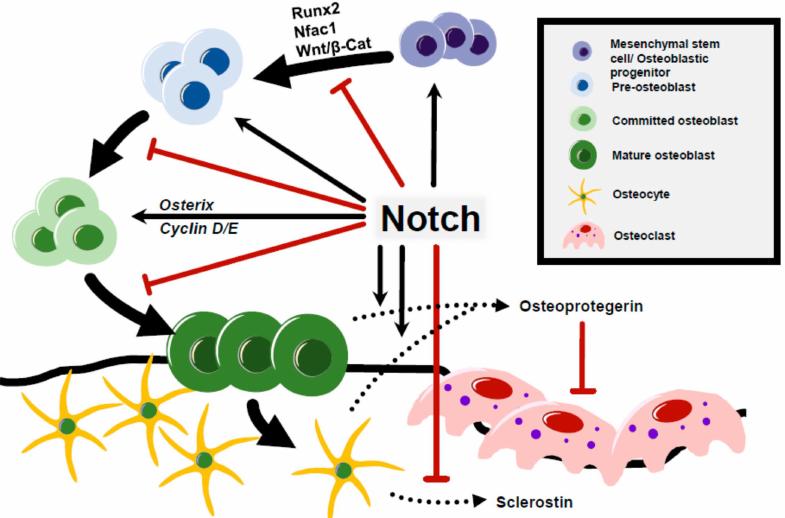
Figure 2. Notch regulation of osteoblast di ff erentiation and osteocyte function. Notch maintains the mesenchymal stem cell (MSC) pool by the repression of Runx2 transactivation on Osteocalcin and suppresses osteoblast di ff erentiation by the Nfatc1-mediated inhibition of Wnt / β -catenin signaling. Expression of Notch increases the immature osteoblast pool by upregulating transcription of Osterix, Cyclin D, and Cyclin E . Notch signaling regulates bone resorption in a non-cell-autonomous manner through Osteoprotegerin expression by osteoblasts and osteocytes. Additionally, Notch activation in osteocytes suppresses sclerostin, which enhances Wnt signaling and inhibits bone